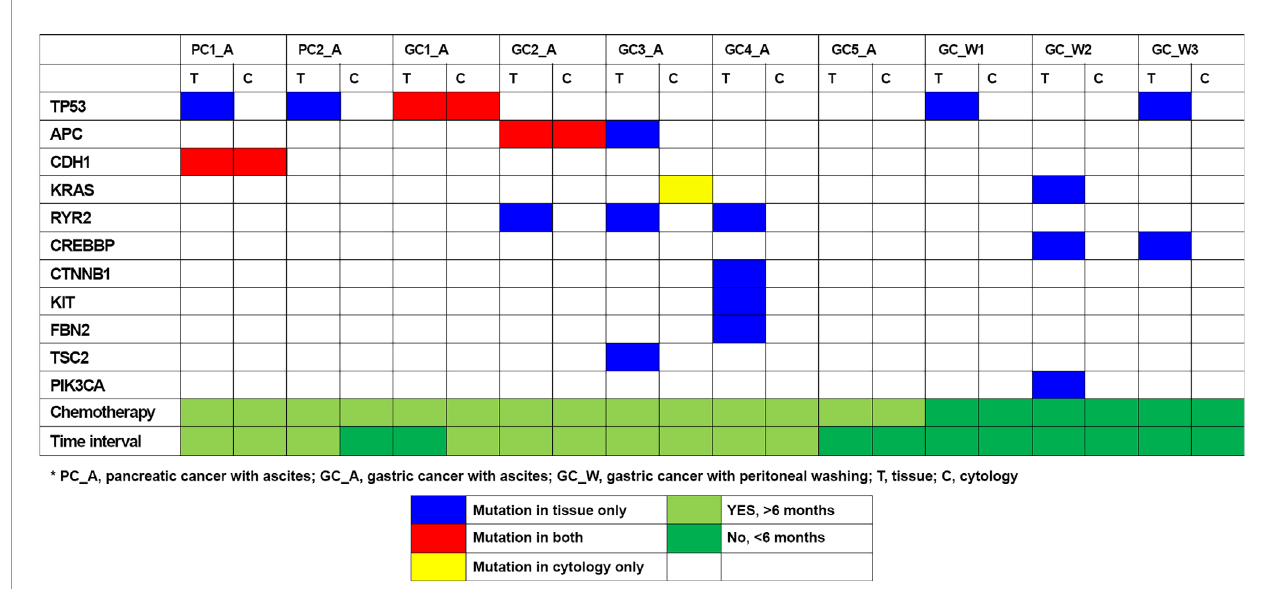
FIGURE 2 | Genomic mutation detection using ascites and peritoneal washing cytology and comparison to tissue sample results.